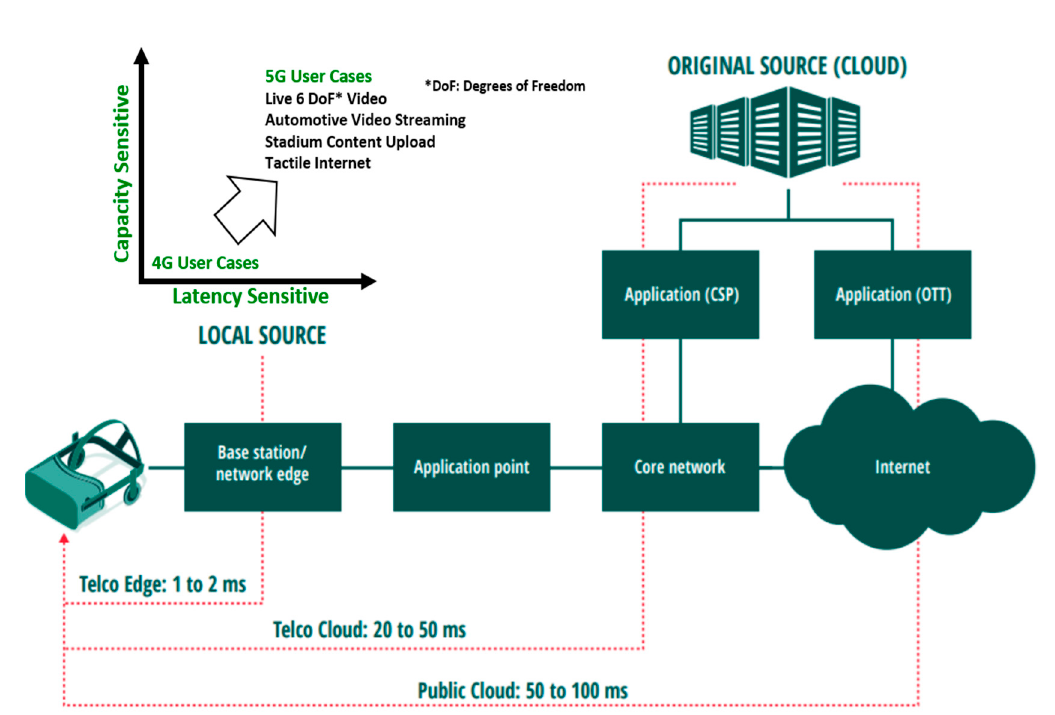
Figure 8. Different network topologies and their associated latencies [38].